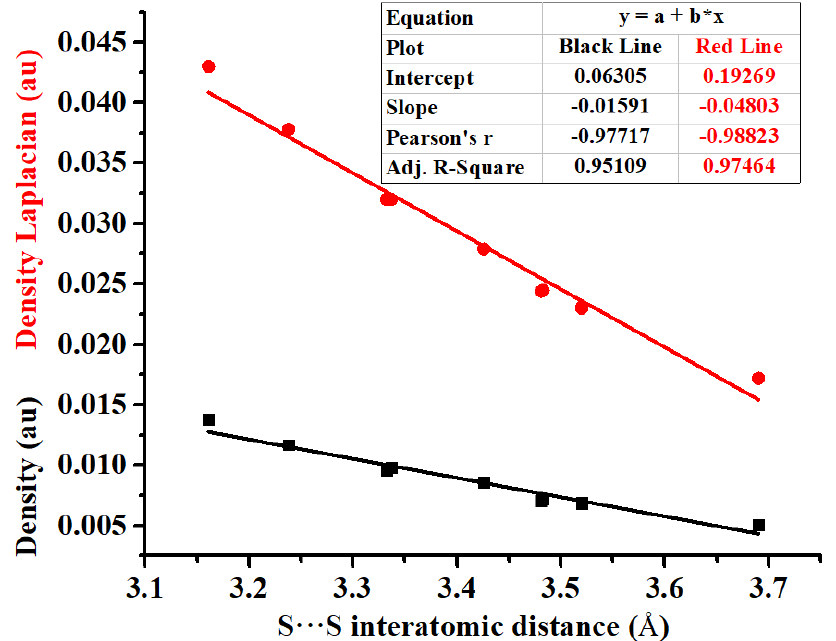
Figure 7. Correlation of the S···S interatomic distance with the electron density (black line) or electron density Laplacian (red line).